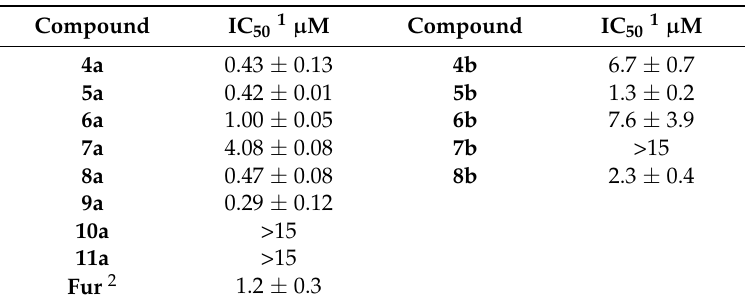
Table 2. Tdp1 Inhibitory activity of compounds 4a , b – 8a , b and 9a – 11a